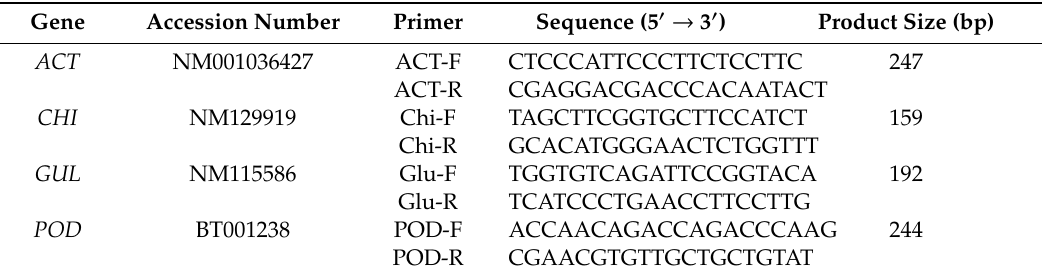
Table 2. Specific primer pairs for the gene expression determinations with quantitative real-time reverse transcription polymerase chain reaction